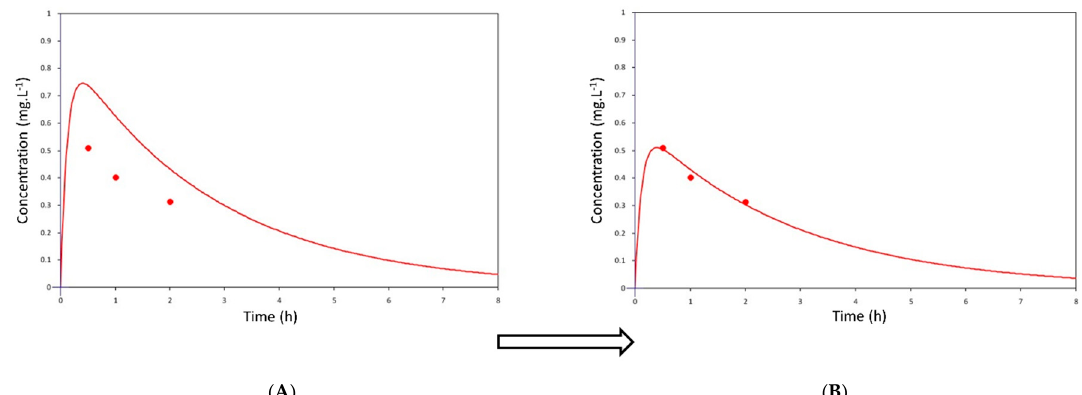
Figure 1. The methodology of pharmacokinetic modeling. Bayesian approach defines all unknown parameters as random variables and via a large number of subsequent iterations the variables are adapted taking into account the physiological and substance properties to achieve maximal fitting of the simulated pharmacokinetic profile curve with the real measured concentration points in each patient. “A priori” concentration-time levobupivacaine population pharmacokinetic profile derived from previously published data [12] and real measured levobupivacaine concentrations in a representative patient from our cohort ( A ). “A posteriori” concentration-time levobupivacaine pharmacokinetic profile is individualized to maximize the fit of the simulated pharmacokinetic profile curve with the observed concentration points in the representative patient ( B ).